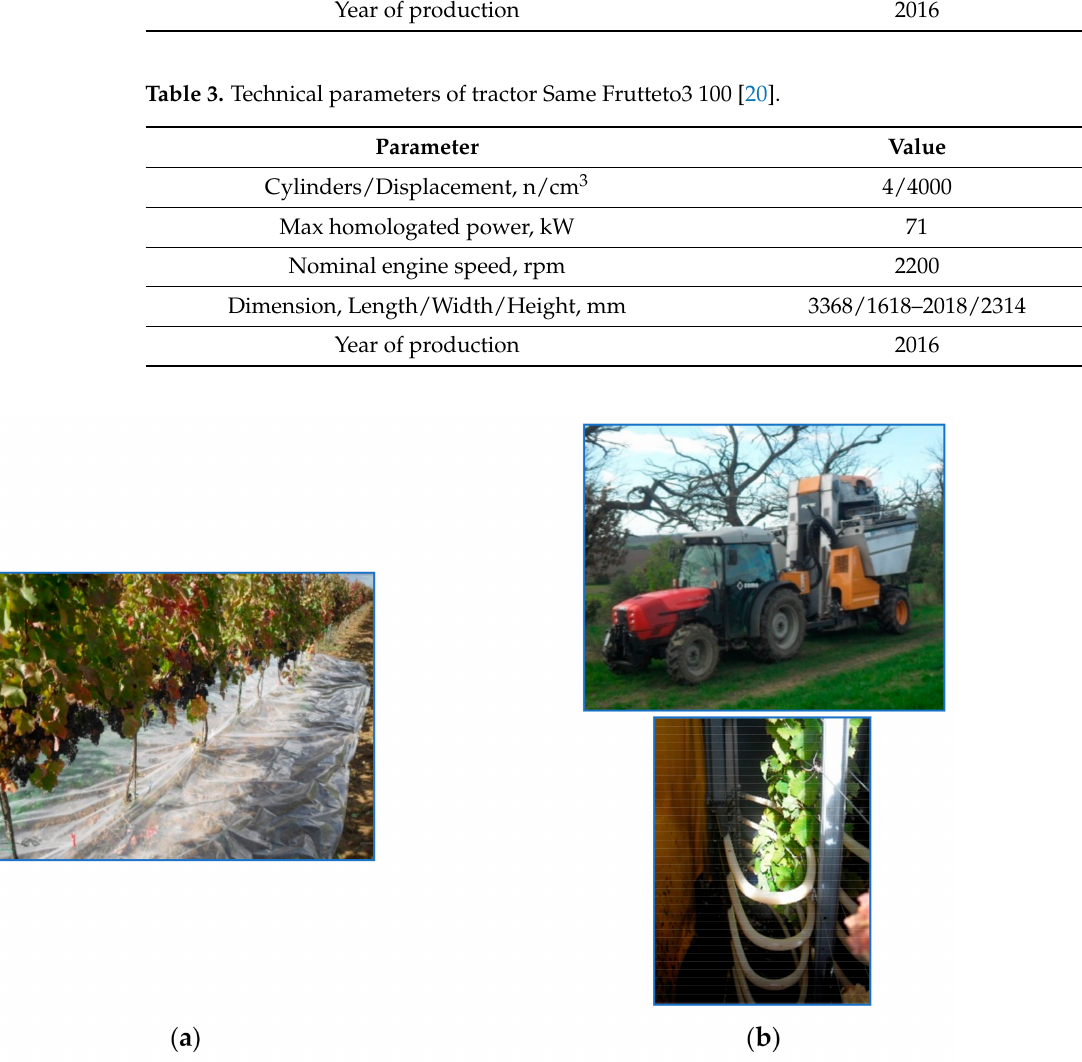
Figure 2. Field experiments and equipment used. ( a )Trial plots; ( b ) Tractor Same Frutteto3 100, trailed grape harvester Pellenc8090 SP and detailed picture of thresher